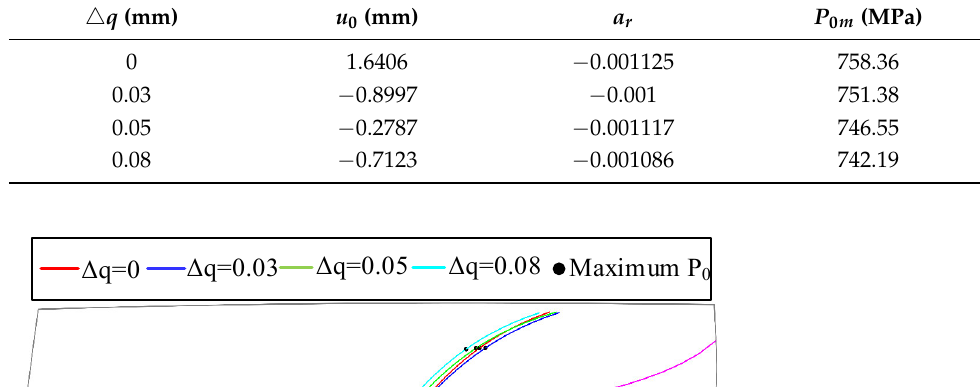
Table 12. Optimization results for different axial displacement errors (cid:52) q .